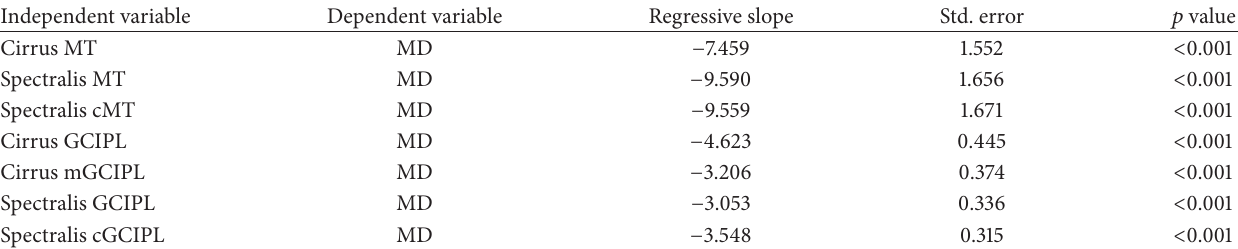
Table 4: Structure-function relationship expressed as regression coefficients and corresponding 𝑝